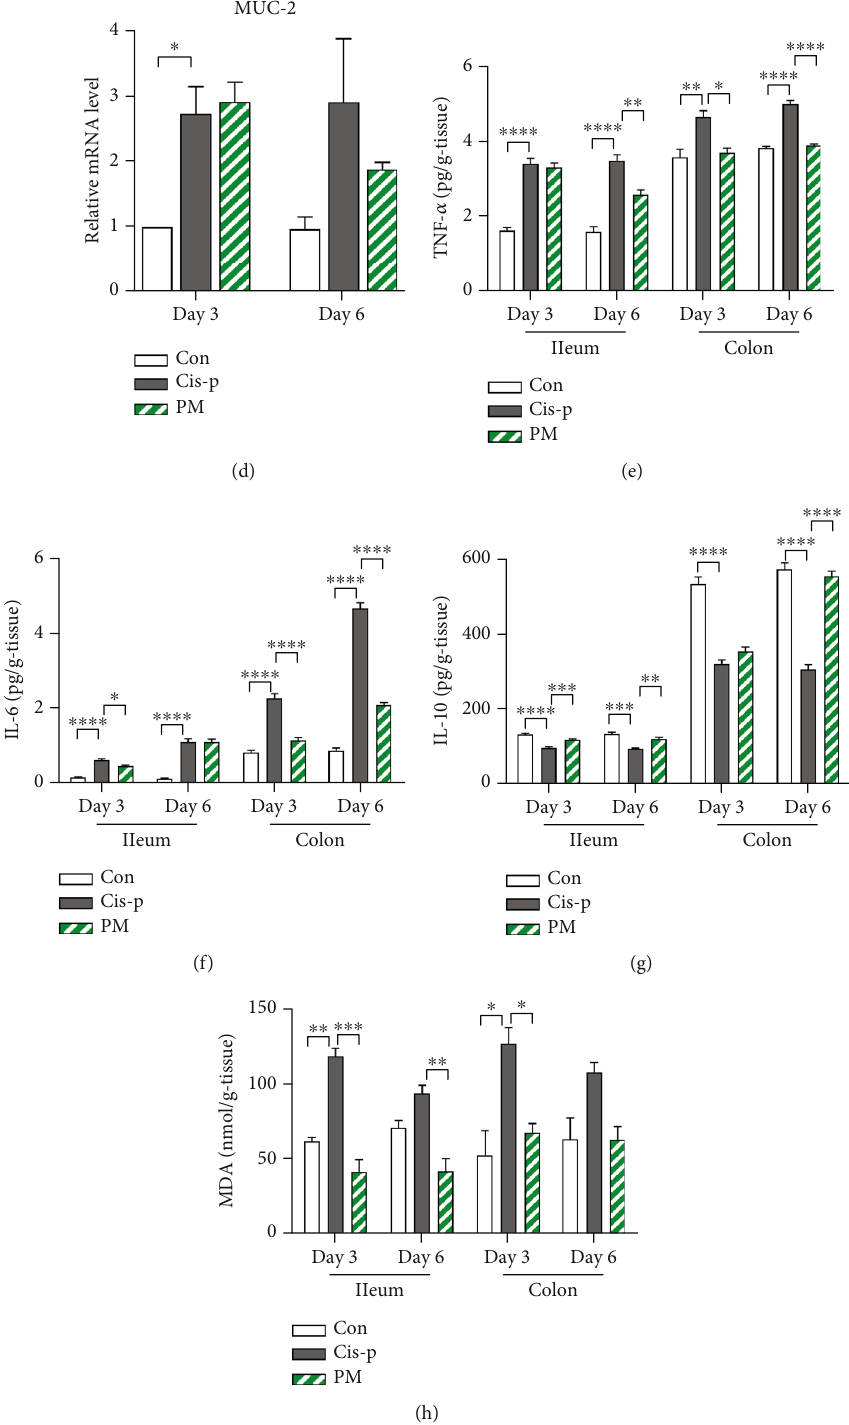
Figure 2: E ff ects of probiotic mixture on the intestinal barrier function in cisplatin-induced mucositis. (a) H&E staining of rat colon sections. (b) Histopathological analysis of H&E-stained sections. (c) Serum LPS were detected by ELISA. (d) Relative mRNA expression of mucin-2 (MUC-2) in colon tissues of rats, detected by quantitative PCR. Levels of tumor necrosis factor- (TNF-) α (e), interleukin- (IL-) 6 (f), IL-10 (g), and malondialdehyde (MDA) (h) in the ileum and colon. Data are expressed as mean ± SEM ( n = 3 -5): ∗ p < 0 : 05 , ∗∗ p < 0 : 01 , ∗∗∗ p < 0 : 001 , and ∗∗∗∗ p < 0 : 0001